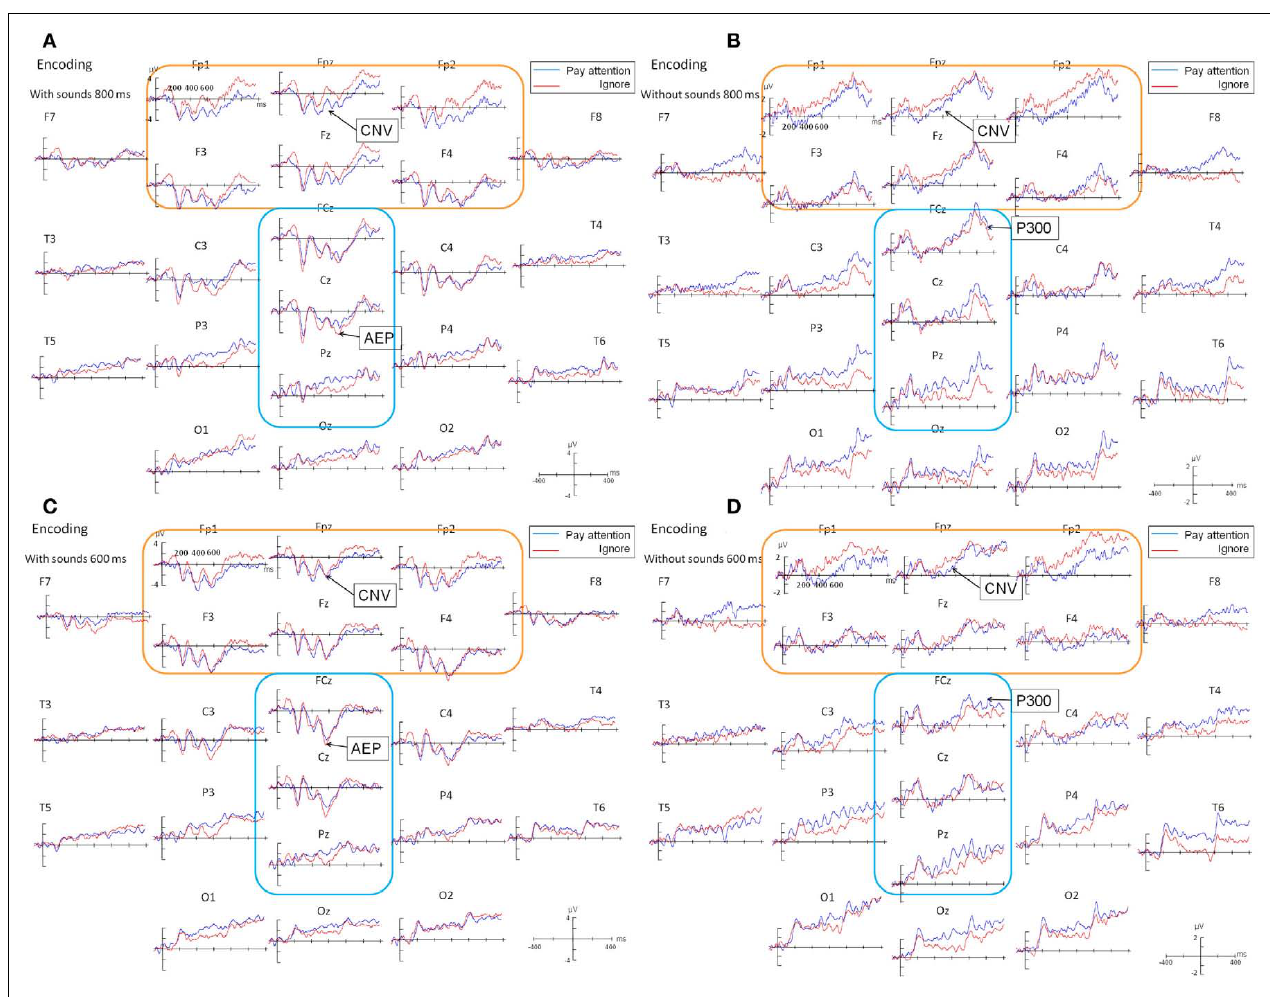
P300. For example, the visual P1 component may have appeared 100ms after the second visual flash in the occipital site, while the CNV have resolved within 200ms after the second flash around the prefrontal site. Because of these co-occurred components, the P300 may seem to develop on many